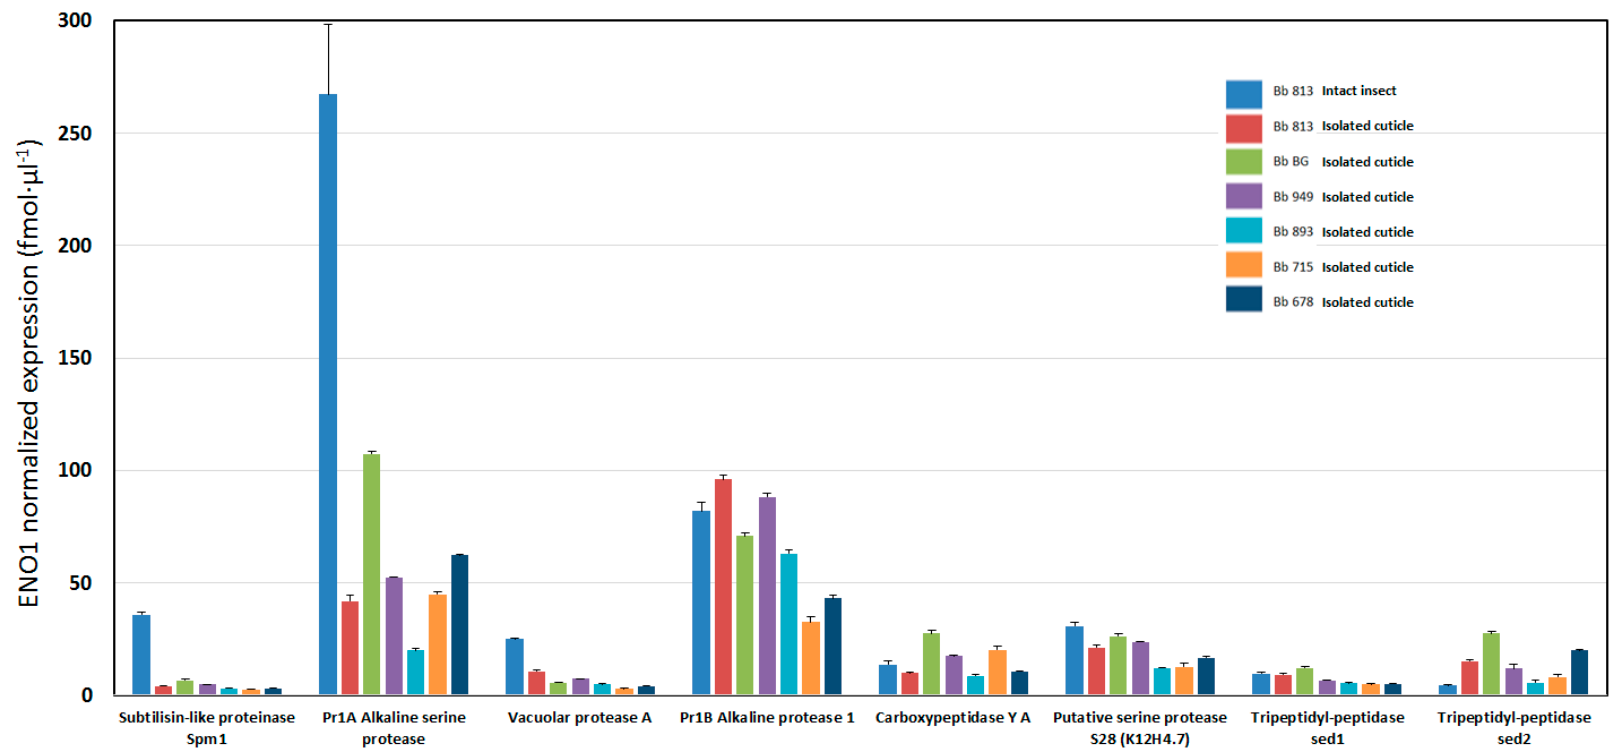
Figure 2. Quantitative label-free proteomics expression of B. bassiana proteolytic exoenzymes detected in different isolates in liquid supernatants after four days of liquid shaking culturing. Isolate Bb 813 was evaluated both in intact and isolated cuticle diet, the other isolates were grown as indicated in the X-axis legend. Uniprot accession numbers for these proteases are listed in Table 2. Means and standard deviations are based on triplicate biological experiments, data were ENO1 normalized and recorded in triplicate technical repeats.